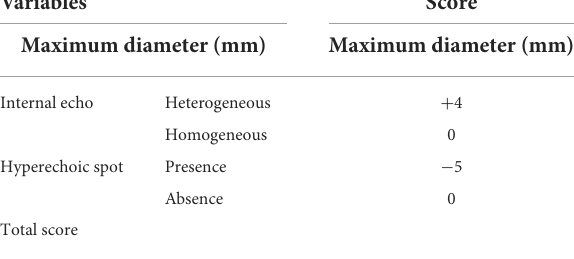
TABLE 2 FB-EUS scoring system by Sadamoto et